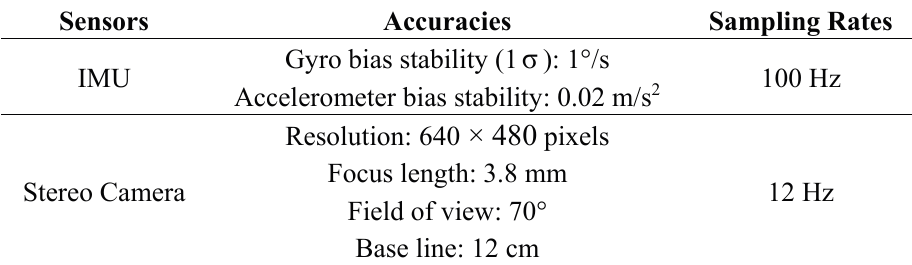
Table 2. The accuracy specifications and sampling rates of the sensors.